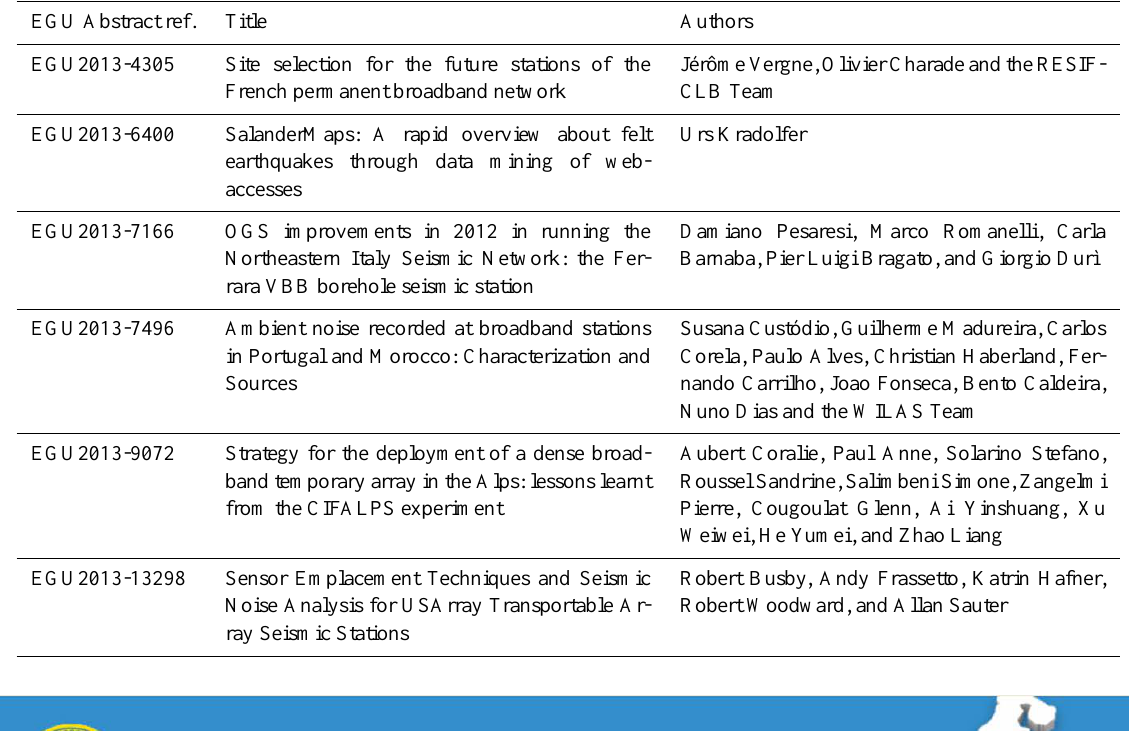
Table 1. Oral Programme EGU2013 SM1.4/GI1.6 session.